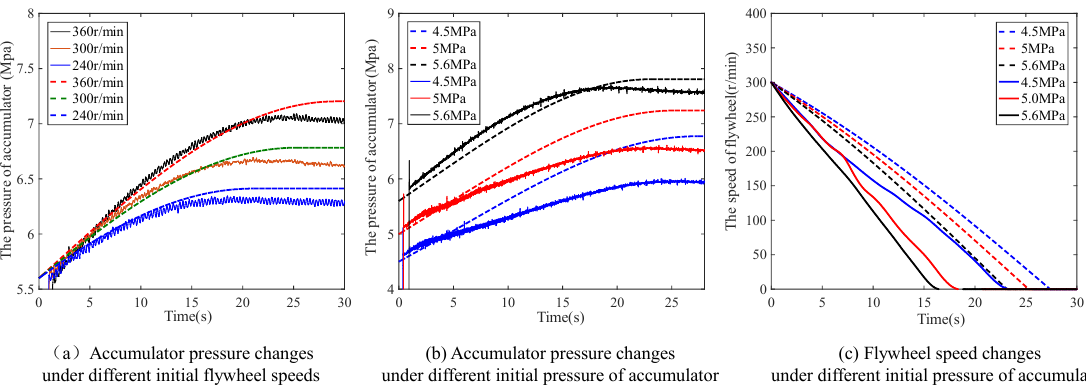
Figure 6. Comparison between bench experiment and simulation results.